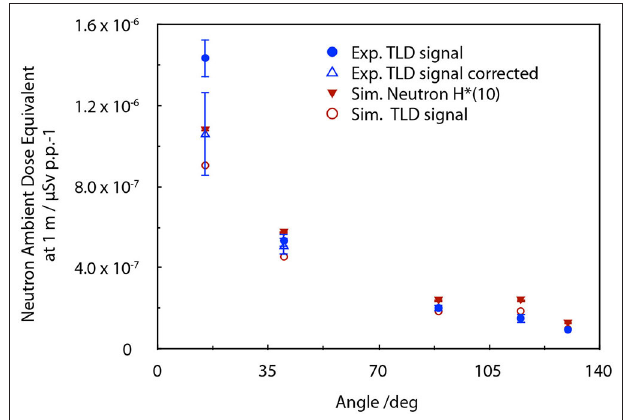
FIGURE 7 | Measured neutron ambient dose equivalent per primary particle at different angles normalized to a distance of 1 m from the target center (see text). Experimental values are presented with (blue open triangles) and without (blue solid circles) secondary proton corrections and compared with the predicted dosimeter response (open red circles) and the predicted neutron ambient dose H *(10) (solid red triangles). Uncertainties bars are partially hidden by the